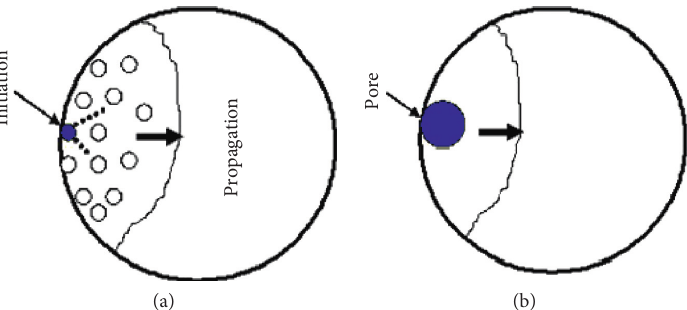
Figure 12: Fatigue crack initiation sites [32]. Thin black arrows point to crack initiation site whereas thick arrow indicates the crack propagation